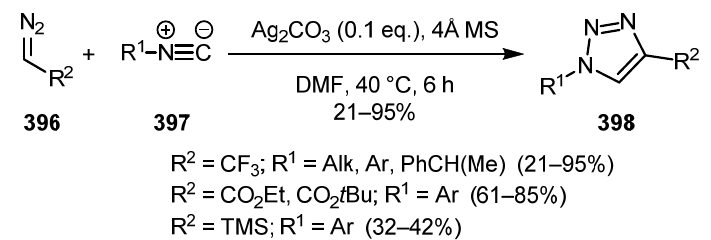
Scheme 100. DBU-promoted reaction of glycine imines with diazo ketones for the synthesis of 1,2,4-triazole-3-carbox- ylates.